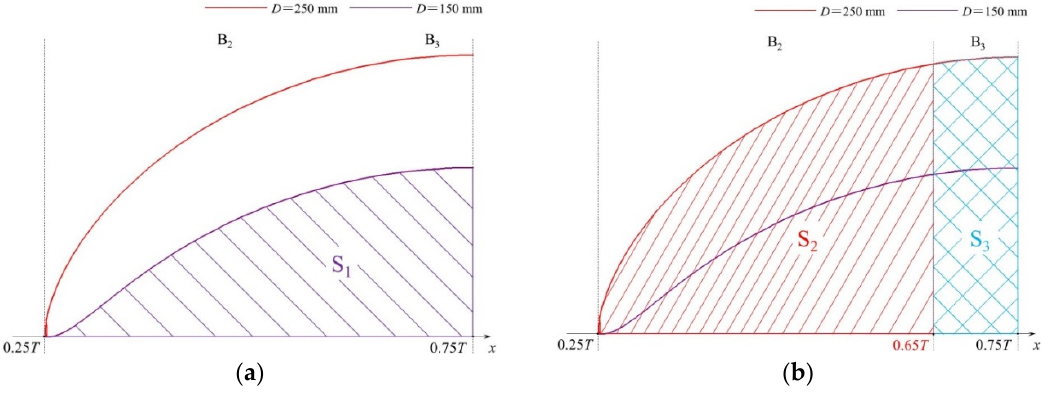
Figure 8. Part of the operating area of the SRB. ( a ) The operating of the SRB when D = 150 mm; ( b ) the operating of the SRB when D = 250 mm. Note: The purple area S 1 is the operating area of the SRB when D = 150 mm; the red area S 2 is the operating area of the SRB when D = 250 mm; the blue area S 3 is the buffer/idling area of the SRB when D = 250